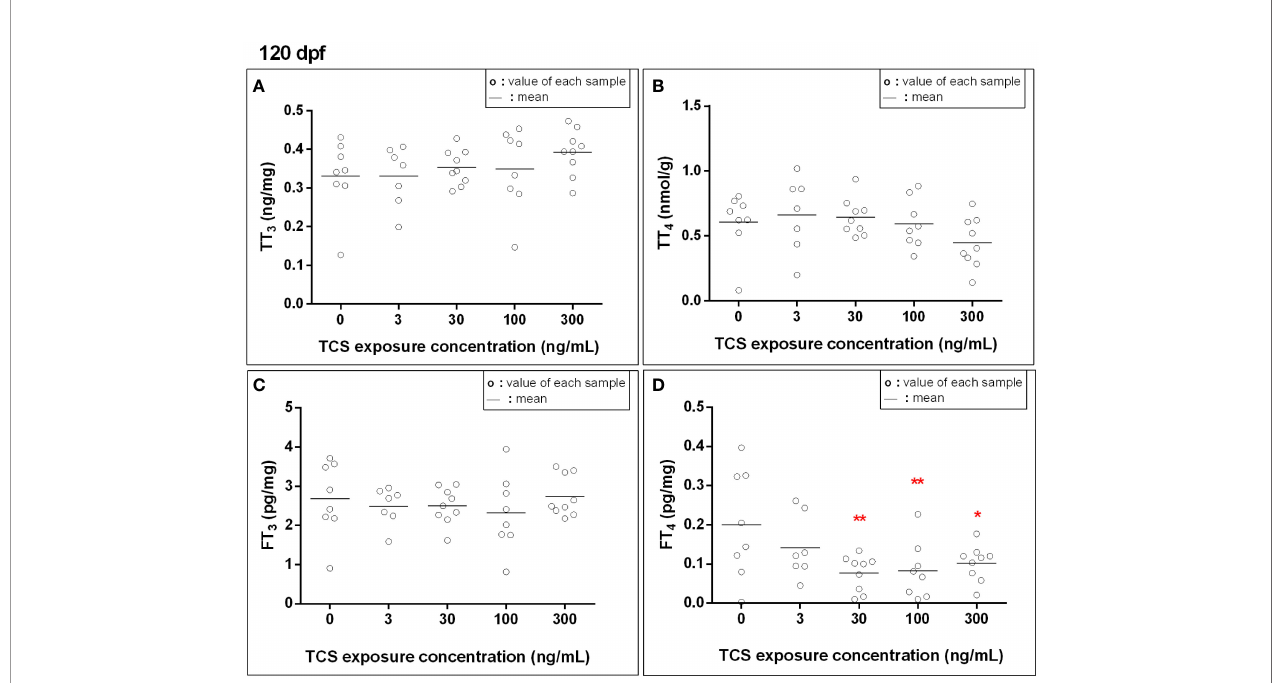
FIGURE 1 | The thyroid hormone levels [ (A) : total triiodothyronine, (B) : total thyroxine, (C) : free triiodothyronine, (D) : free thyroxine] in zebra fi sh exposed to TCS for 120 days after fertilizing. Thyroid hormone concentrations in fi sh at 120 dpf were measured for each exposure group, with each sample homogenized from every